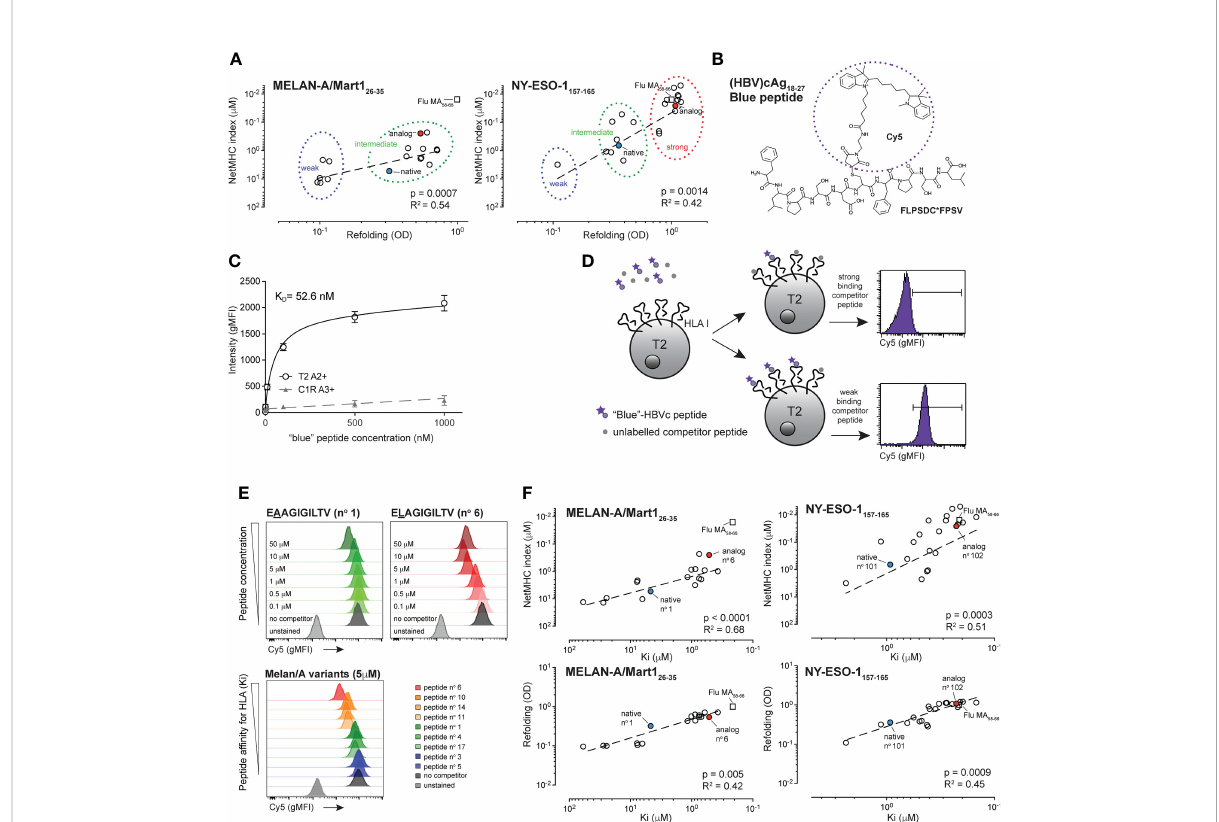
FIGURE 1 Biophysical characterization of the HBV-speci fi c blue peptide and selection of Melan-A/MART1 26-35 and NY-ESO-1 157-165 -speci fi c peptide variants. (A) Correlation between NetMHC4.0 and binding assay refolding indexes: Melan-A 26-35 peptide variants (left graph) segregate into weak (blue circle) and intermediate (green circle) binding peptides. NY-ESO-1 157-165 peptide variants (right graph) segregate into weak (blue circle), intermediate (green circle) and strong (red circle) binding peptides. Native and analog peptides are shown in blue and red, respectively. Flu Matrix 58-66 control peptide is shown for comparison purposes (square). R square and p values were obtained from Pearson correlation analysis. (B) Chemical structure and sequence of the HLA-A2-restricted Hepatitis B virus (HBV) cAg 18-27 (FLPSDC*-(Cy5) FPSV) blue peptide. (C) Representative experiment from concentration isotherm assays to characterize the K D binding af fi nity of the HBVc-Cy5 blue peptide for HLA-A2 (n = 5). (D) Principles of the HBVc-Cy5 blue peptide cell-based competition assay. The binding strength of peptide variants to HLA-A2 complex was determined through competition assays on T2 cells between titrated amount of unlabelled competitor peptide and a fi xed concentration of HBVc-Cy5 blue peptide. Examples from competition with a strong or a weak binding peptide are shown. (E) Blue peptide assay readouts showing titration Cy5 gMFI histograms (upper panels) at different Melan-A peptide concentrations (native EAAGIGILTV (n°1) and analog ELAGIGILTV (n°6) are shown) and with competition peptide variants having distinct af fi nities for HLA-A2 (lower panel). Positive control is done with the “ blue ” -HBVc-Cy5 peptide alone and negative control corresponds to the auto fl uorescence of T2 cells. (F) Correlation between K i af fi nities ( m M) obtained from the cellular blue peptide competition assay and values obtained from the soluble refolding assay (OD) or from the NetMHC4.0 algorithm for both NY-ESO-1 (left) and Melan-A/MART1 (right) variants. Native and analog peptides are shown in blue and red for both peptides, respectively. Flu Matrix 58-66 control peptide is shown for comparison purposes